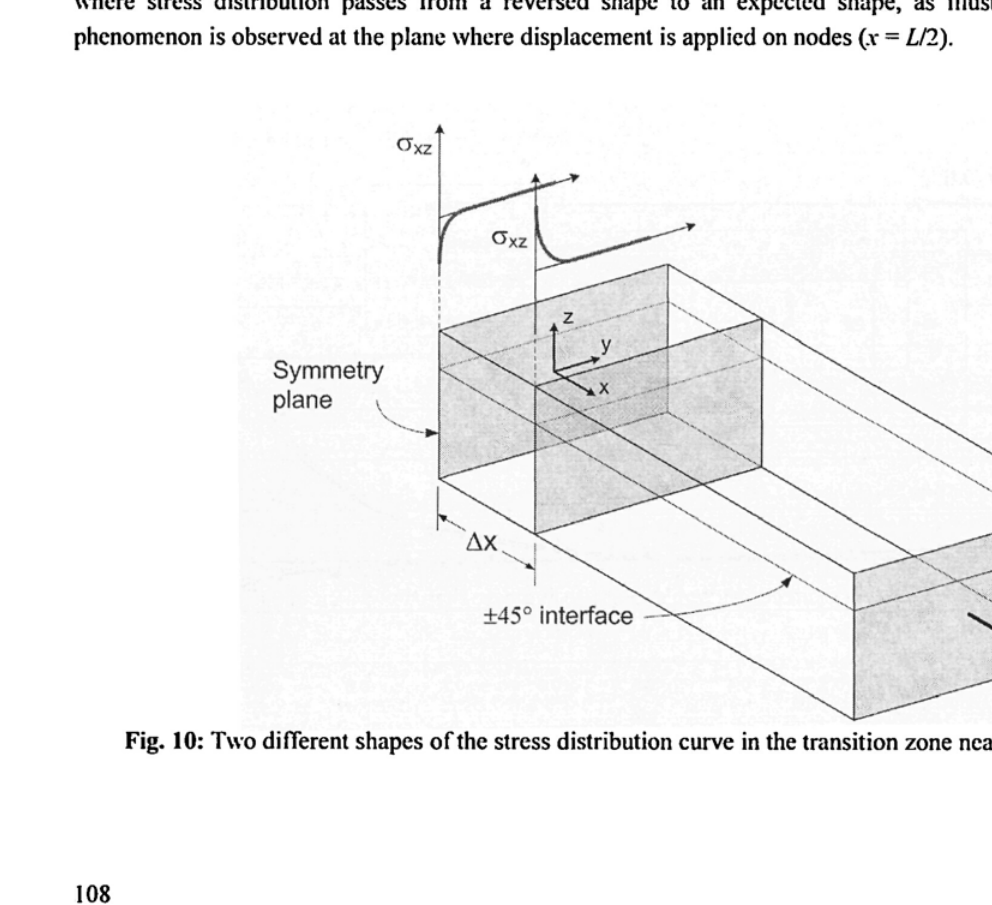
Fig. 9: σ distribution along _y-axis at 90/0 interface (ref. curve taken from 1221) >>ζ